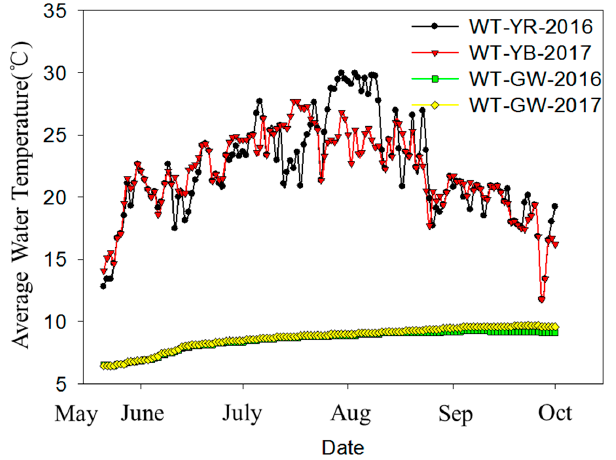
Figure 4. The temperature of irrigation water.